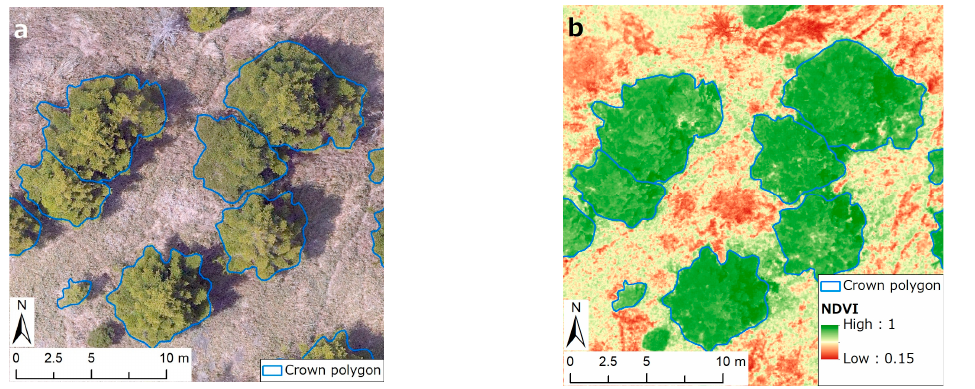
Figure 3. Examples of tree crown polygons. ( a ) Orthomosaic image of visible light (DJI P1); ( b ) orthomosaic image of NDVI.